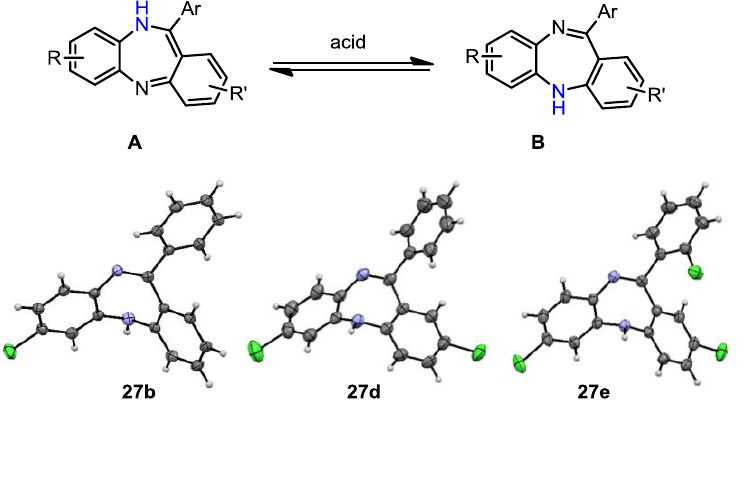
Scheme 5. Tautomer interconversion and X-ray crystal structures of compounds 27b , 27d and 27e (nitrogen: blue; chlorine: